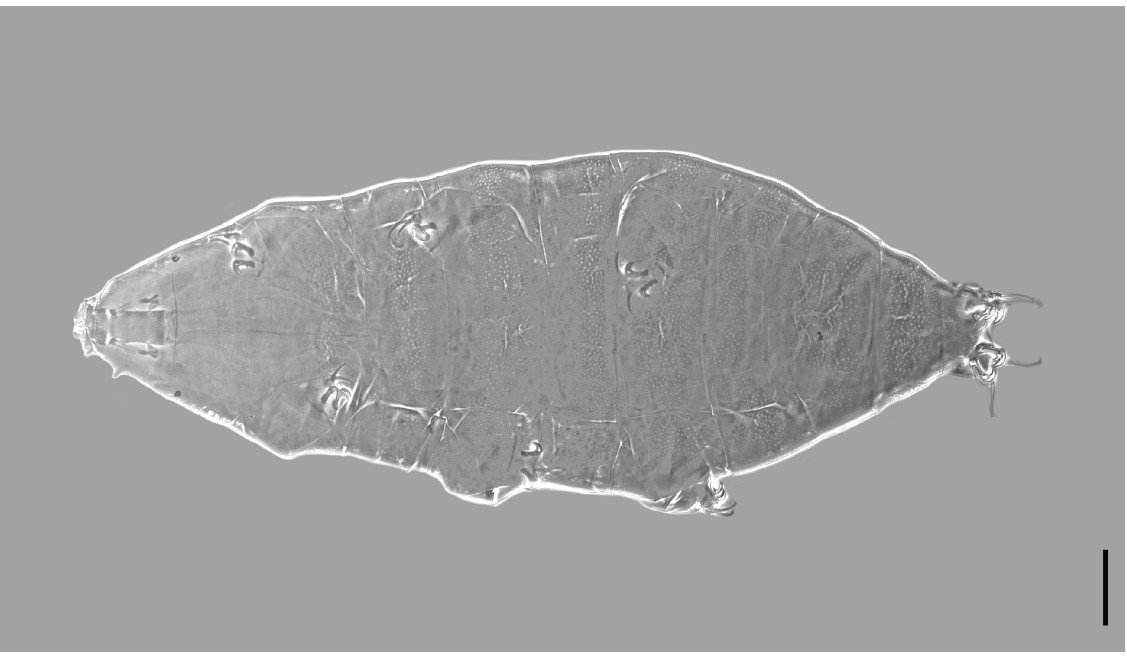
Fig. 8. Milnesium pelufforum sp. nov., holotype, ♀ (slide No. MCNS tar. 000021-3). Habitus. Scale bar = 50